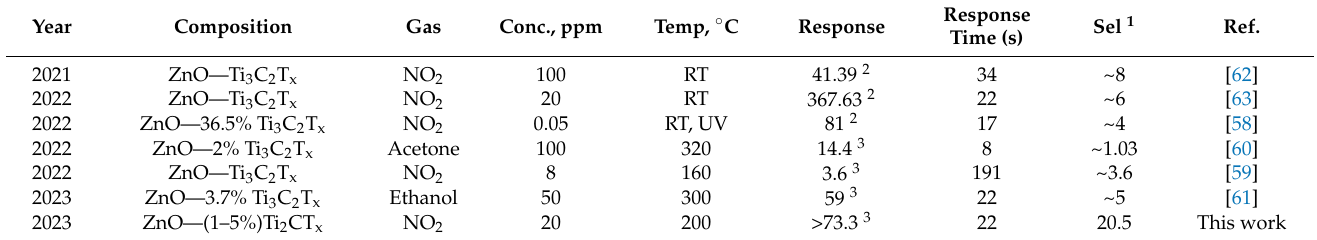
Table 1. Comparison of gas sensing properties of ZnO/Ti 2 CT x and ZnO/Ti 3 C 2 T x nanocomposites reported in the